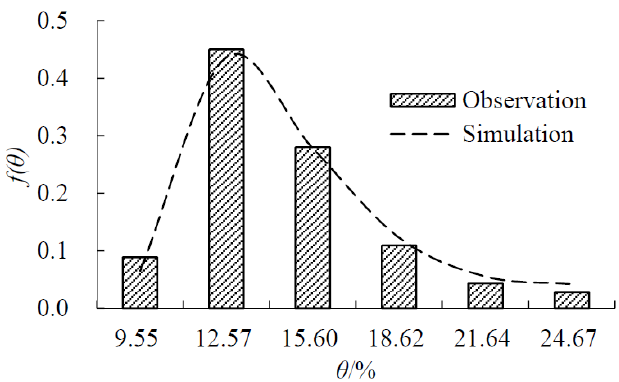
Figure 6. Probability distribution of observed and simulated θ in calibration period.